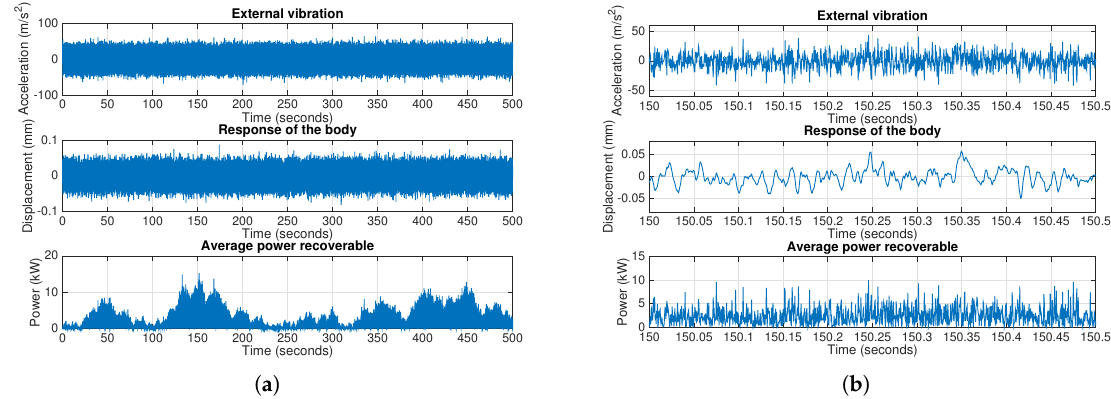
Figure 7. Input and response when subjected to band-limited (0 Hz–2 kHz) white noise with a noise intensity of 9.8 × 10 − 4 g 2 /Hz. ( a ) View over 500 s; ( b ) zoomed view for 0.5 s.